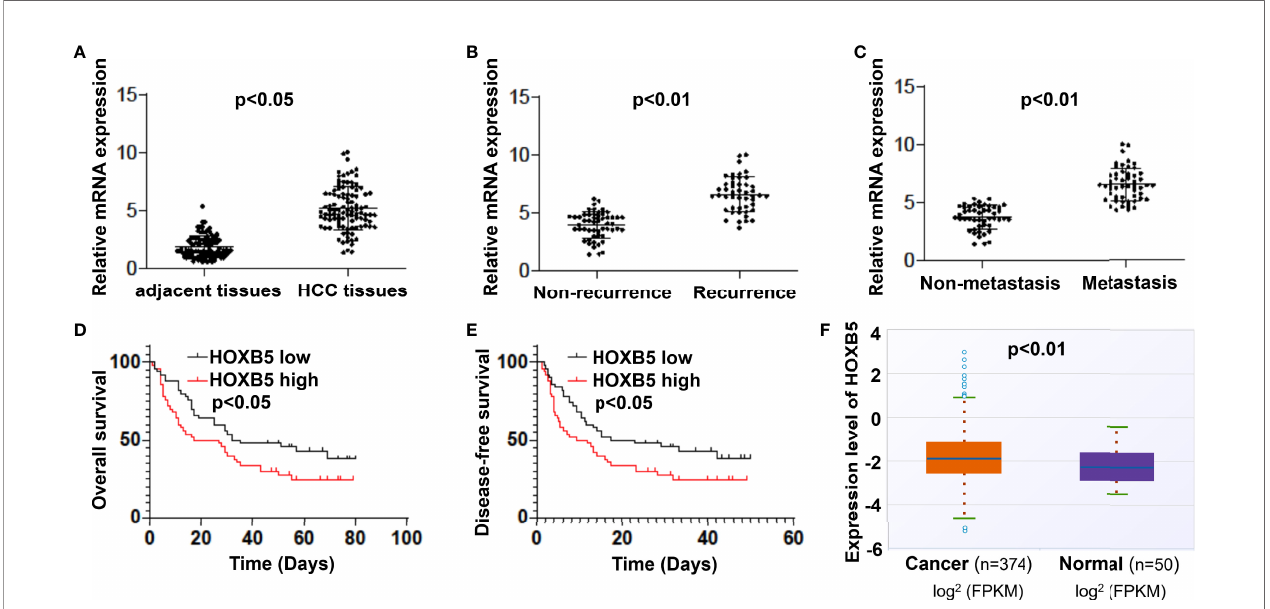
FIGURE 1 | Elevated expression of HOXB5 is frequently found in HCC patients and positively correlates with poor prognosis. (A) mRNA expression level of HOXB5 in 100 pairs of HCC tissues and adjacent non-tumor tissues was evaluated by qRT-PCR. Data are mean ± SD, n = 100. (B) mRNA levels of HOXB5 were signi fi cantly higher in recurrence patients than in patients free of recurrence. (C) The HOXB5 expression level was much higher in metastasis patients than in patients free of metastasis. (D, E) Kaplan – Meier curve of HOXB5 depicting the OS and DFS of HCC patients. (F) mRNA expression of HOXB5 in human HCC was evaluated in a public database.